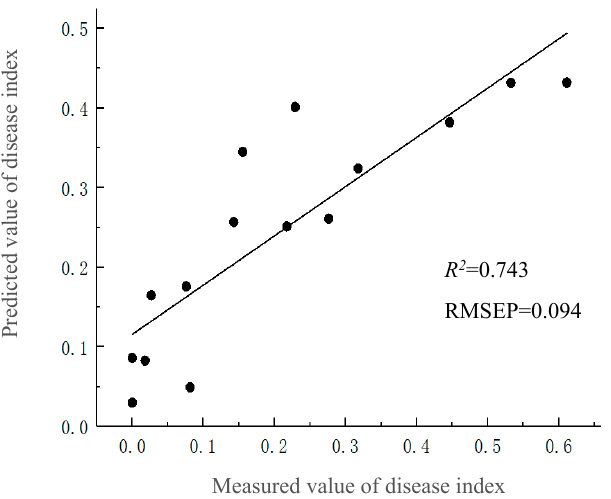
Figure 5. Accuracy verification of wheat take-all prediction results.